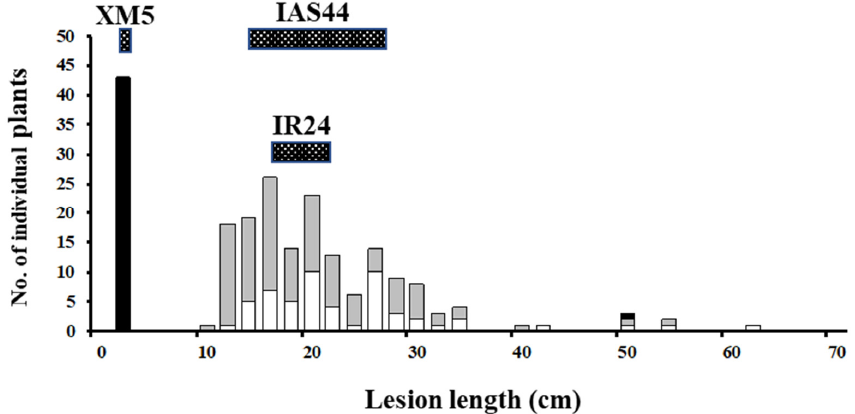
Figure 1. Frequency distribution of lesion length at 18 days after inoculation with Xoo Japanese race II (T7147) of the F 2 population from the cross between XM5 and IAS44. The classified genotypes were assessed for RM6728 as noted: black, homozygous for XM5; gray, heterozygous; white, homozygous for IAS44. XM5 (10 plants), IAS44 (5 plants) and IR24 (10 plants) were planted as reference, and their lesion length ranges are shown as stippled boxes on the top. Table 5. Genotypes of informative recombinants for the DNA marker loci linked with xa19 on chromosome 7 in the F 2 population (XM5 × IAS44), and the gene segregation in the F 3